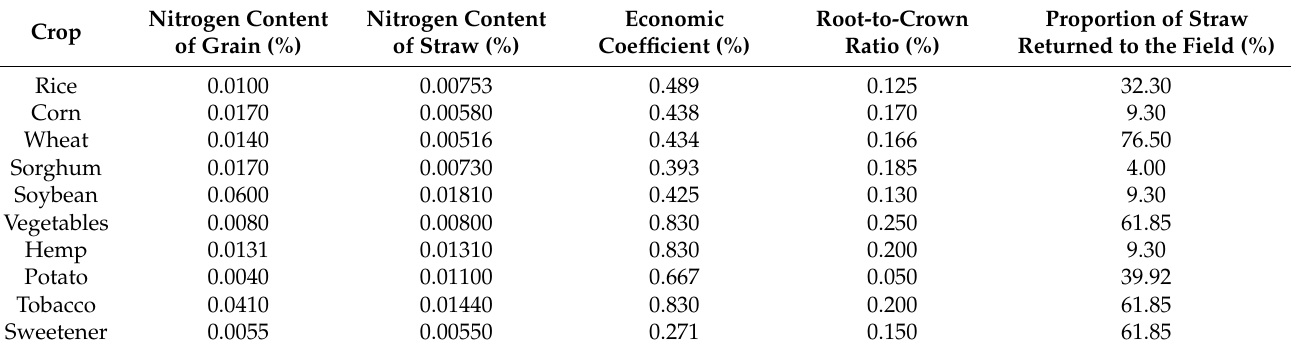
Table 2. Nitrous oxide emission parameters of main crops.